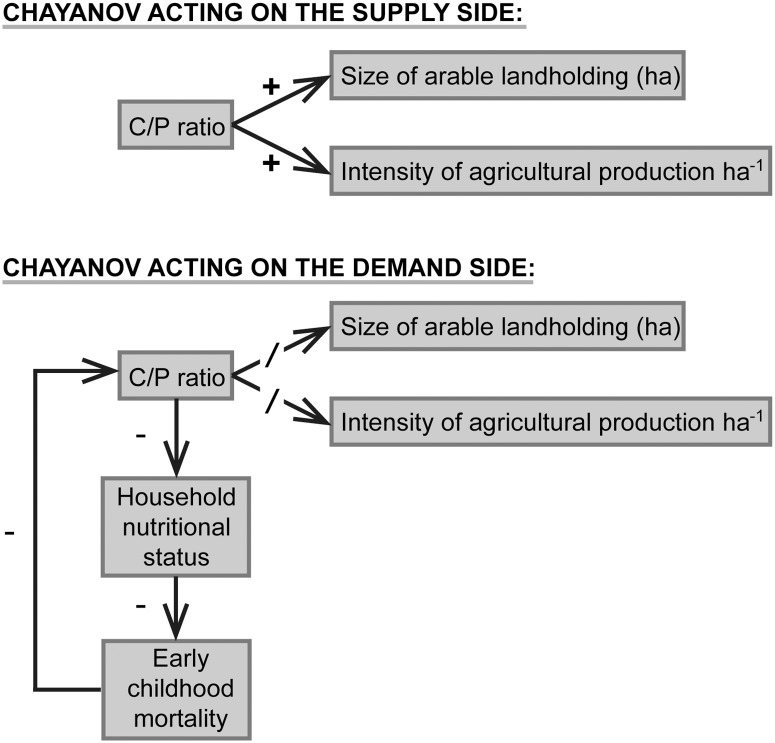
The conventional model that has C/P ratio acting purely on the supply side of the household economy (top) and an extended model that allows for possible effects on the demand side when supply-side responses are blocked or impeded (bottom).Pluses and minuses indicate the direction of the bivariate relationship between boxes.